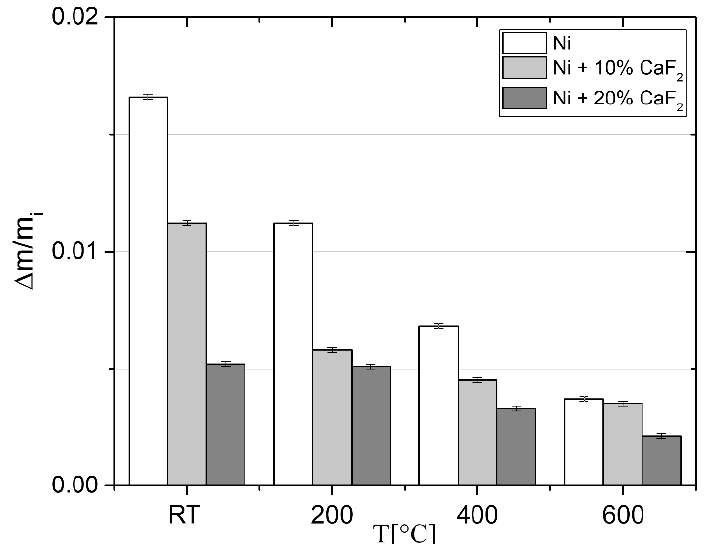
Figure 3. Relative loss of mass of the counter-samples.